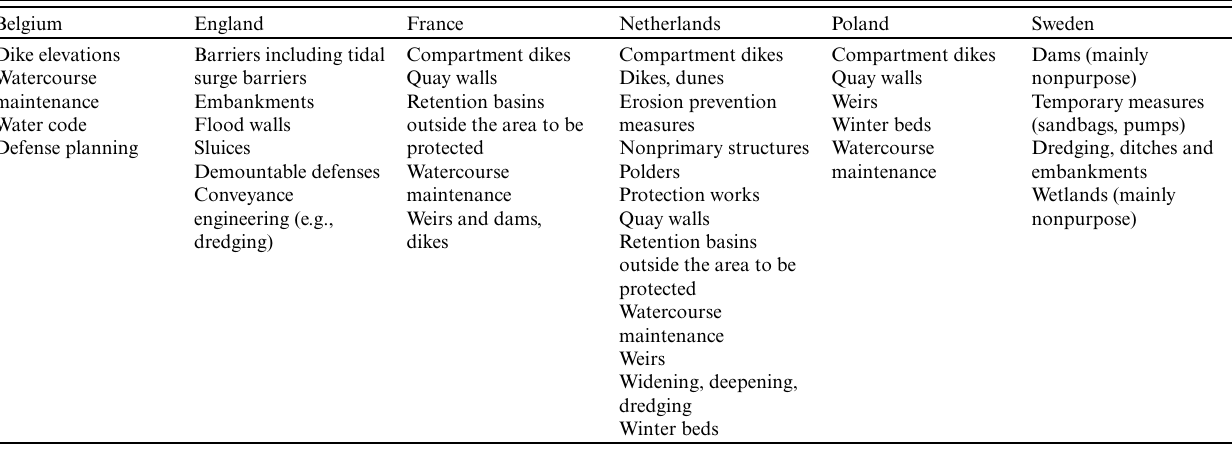
Table 1 . Flood defense measures in the six selected countries.